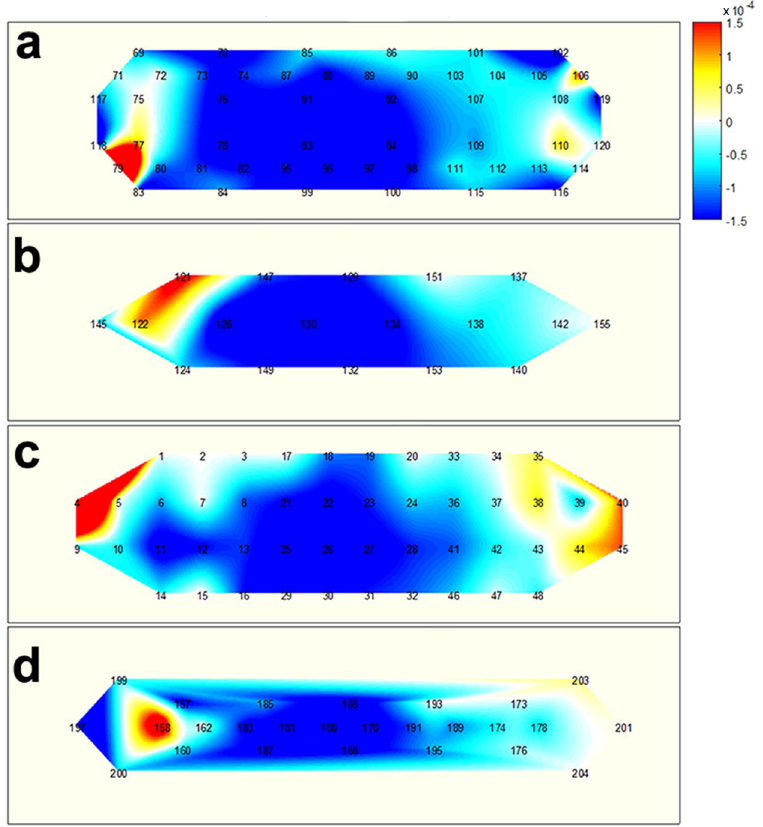
Figure 5. Hemodynamic variations ( Δ HbO) induced by WC and measured by using four SD separations 15 s after task onset: ( a ) 15 mm, ( b ) 21.2 mm, ( c ) 30 mm, and ( d ) 33.5 mm. The numbers in each subfigure denote the locations of NIRS channels. The vertical colour bar indicates the range in